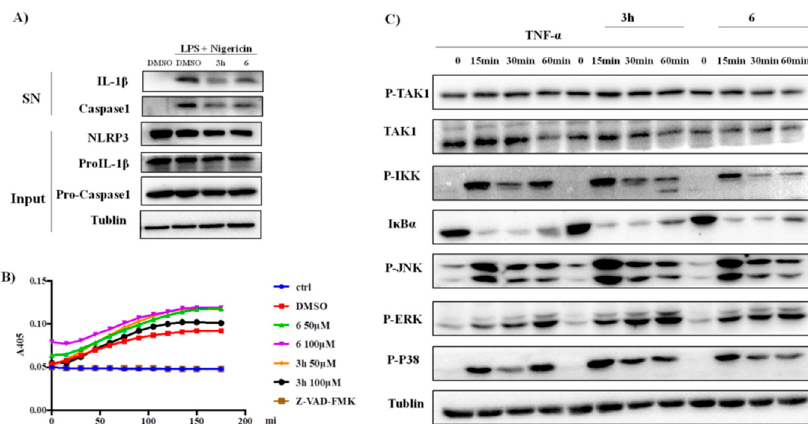
Figure 4. ( A ) Immunoblot analysis of indicated proteins in culture supernatants (SN) and cell lysis (Input) of PMA primed THP-1 cells treated with target compounds (5 µ M) and then stimulated with LPS (5 µ g/mL) and NIG (20 µ M). ( B ) Caspase 1 activity assay for purified caspase1 with or without presence of compounds 3h and 6 or positive control. ( C ) Immunoblot analysis of NF- κ B and MAPK signaling pathway in 293 cells treated with TNF- α (20 ng/mL) with or without compounds 3h and 6 (5 µ M). The protein levels were normalized against tublin.